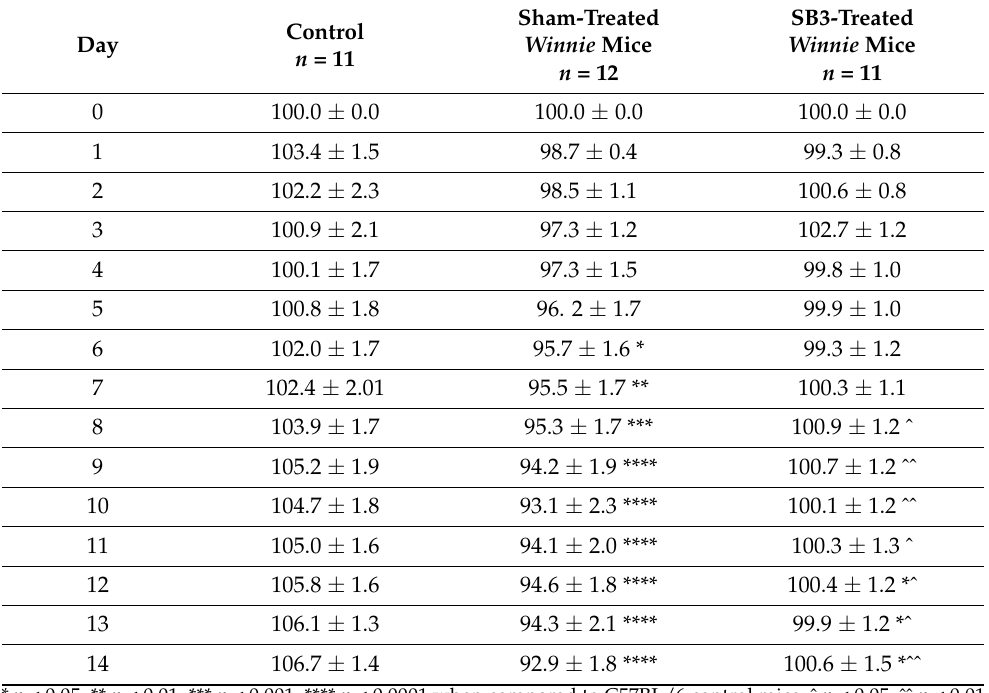
Table 1. Changes to body weights of C57BL/6 control, sham-treated, and SB3-treated Winnie mice. Control Day n =